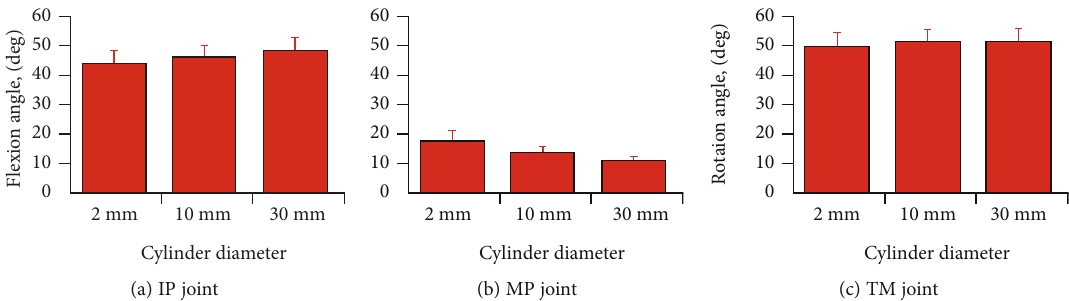
Figure 4: Mean fl exion and rotation angle of each thumb joint when cylinders of di ff erent diameters were pinched. The error bars indicate the standard error.